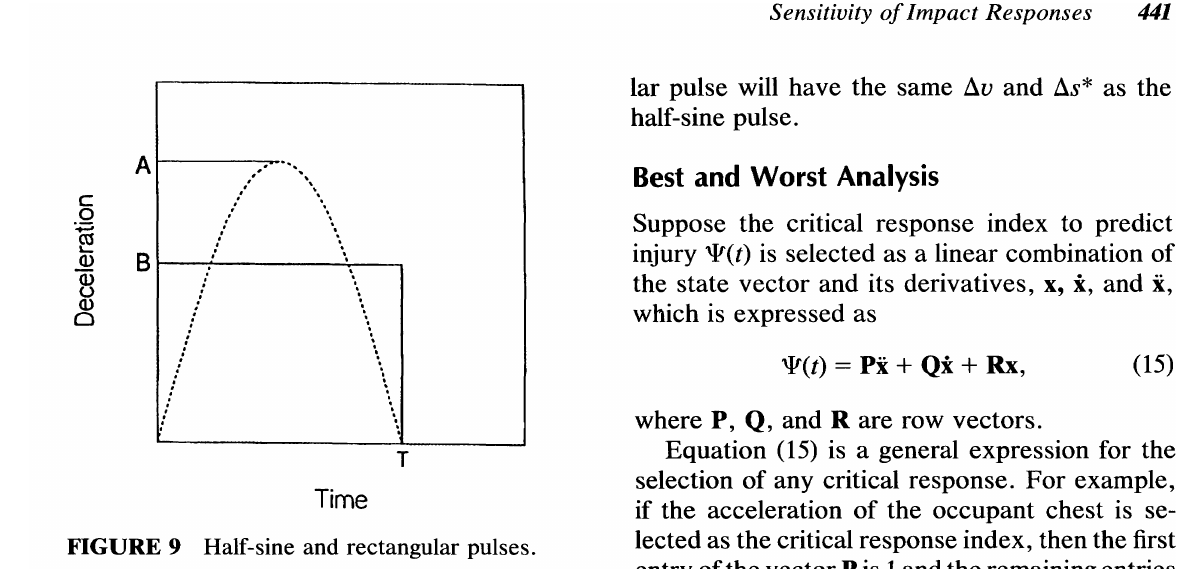
FIGURE 9 Half-sine and rectangular